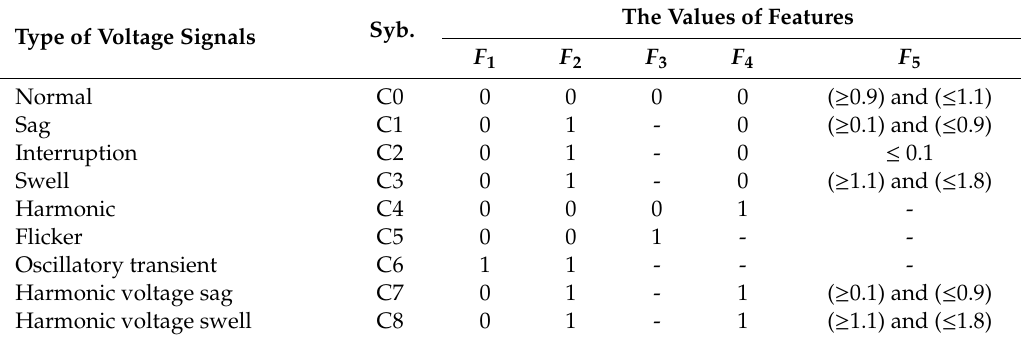
Table 1. PQ disturbance values.